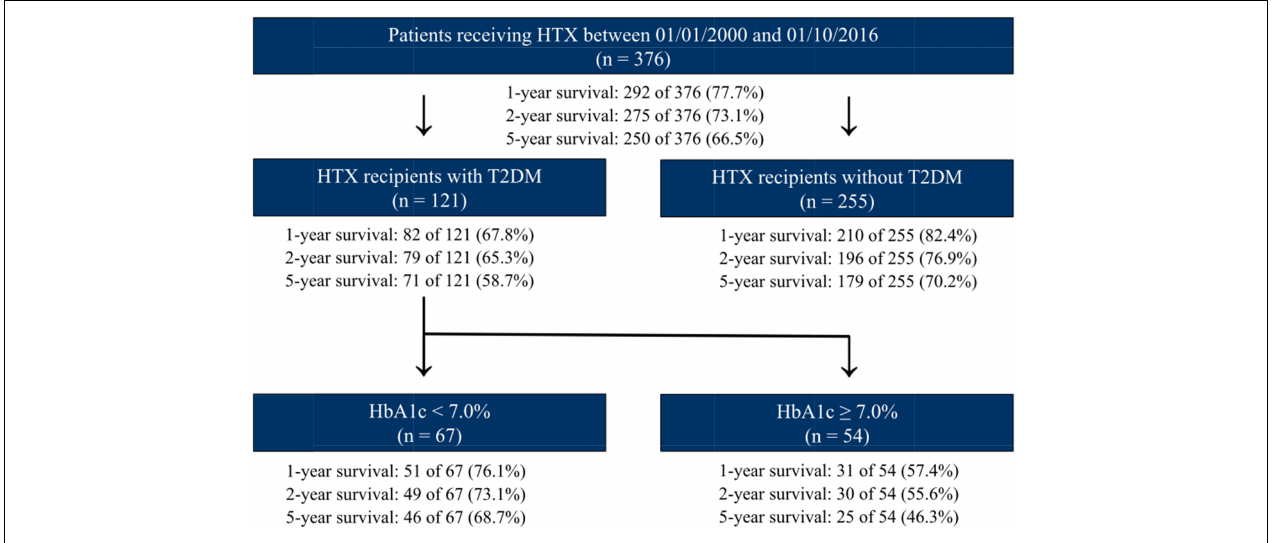
FIGURE 3 | Overview of 5-year post-transplant survival stratified by T2DM at HTX and HbA1c at HTX. Patients without T2DM at HTX showed the best 1-, 2-, and 5-year post-transplant survival, followed by patients with T2DM at HTX and a HbA1c < 7.0% at HTX, whereas patients with T2DM at HTX and a HbA1c ≥ 7.0% at HTX had the worst 1-, 2-, and 5-year post-transplant survival. HbA1c, hemoglobin A1c; HTX, heart transplantation; n, number; T2DM, type 2 diabetes mellitus.